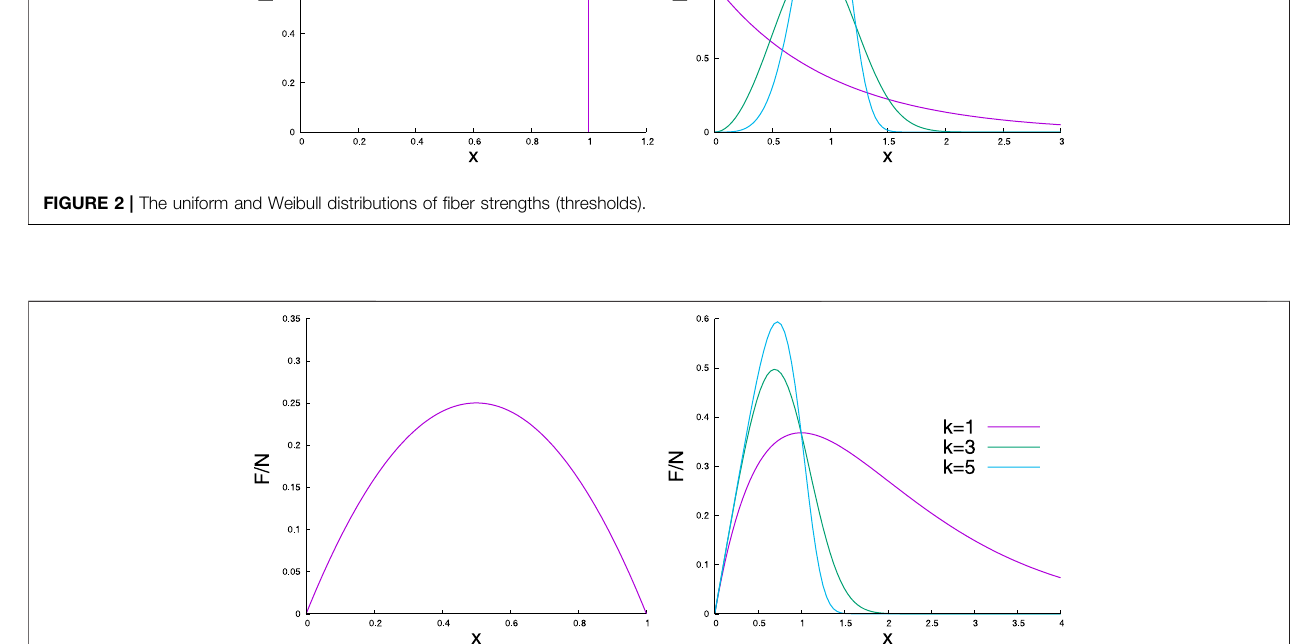
FIGURE 3 | Normalized force ( F / N ) against extension x for a fi ber bundle with uniform ( x c (cid:1) 0 . 5 ) and Weibull x c (cid:1) 1 , ( 1/3 ) 1/3 , ( 1/5 ) 1/5 for k (cid:1) 1 , 3 , 5, respectively, distributions of strengths (thresholds).